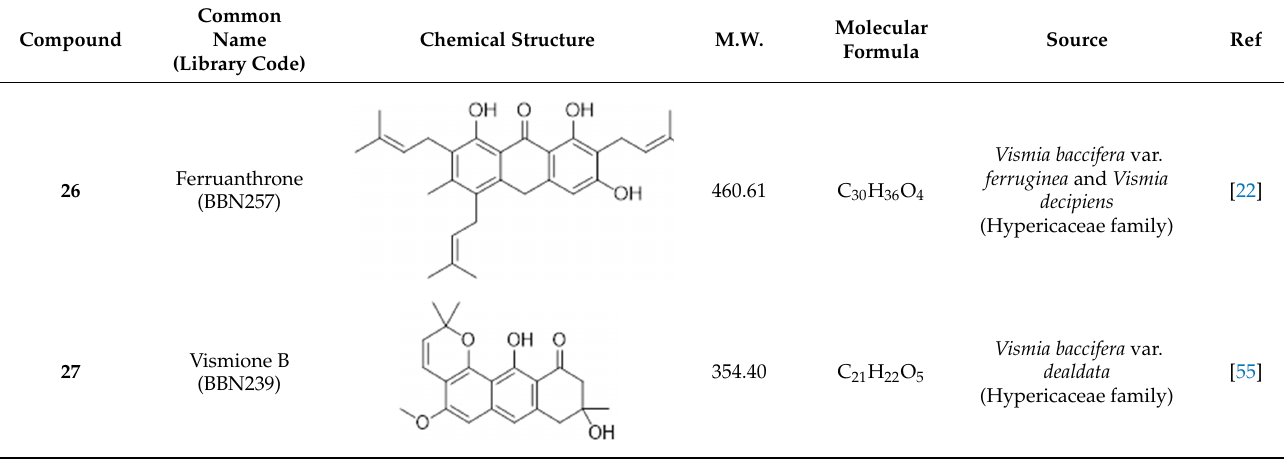
Table 3. General features of the two structural related anthranoids, i.e., 26 and 27 .